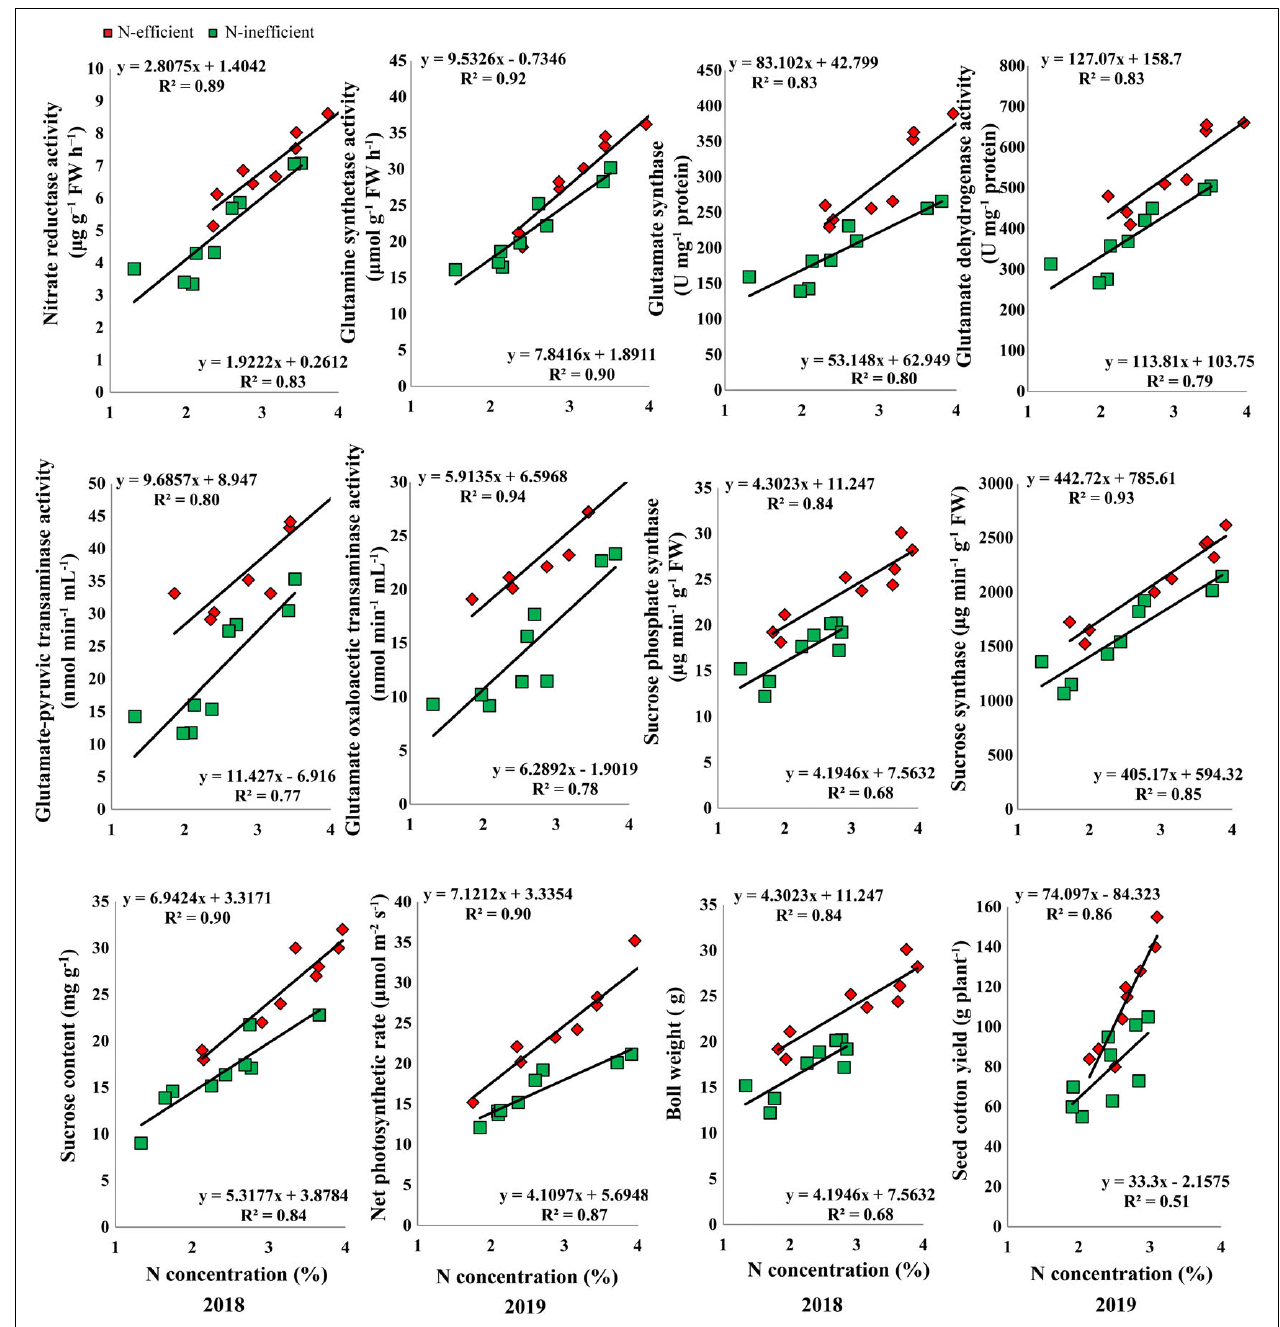
FIGURE 7 | Relationships of subtending leaf N concentration (%) with nitrate reductase ( µ g g − 1 FW h − 1 ), glutamine synthetase activity ( µ mol g − 1 FW h − 1 ), glutamate synthase (U mg − 1 protein) and dehydrogenase activity (U mg − 1 protein), glutamate–pyruvic transaminase activity (nmol min − 1 mL − 1 ), glutamate oxaloacetic transaminase activity (nmol min − 1 mL − 1 ), sucrose phosphate synthase ( µ g min − 1 g − 1 FW), sucrose synthase ( µ g min − 1 g − 1 FW), sucrose content (mg g − 1 FW), net photosynthetic rate ( µ mol m − 2 s − 1 ), boll weight (g), and seed cotton yield (g plant − 1 ) of N-efficient (CCRI-69) and N-inefficient (XLZ-30) cotton genotypes under hydroponic